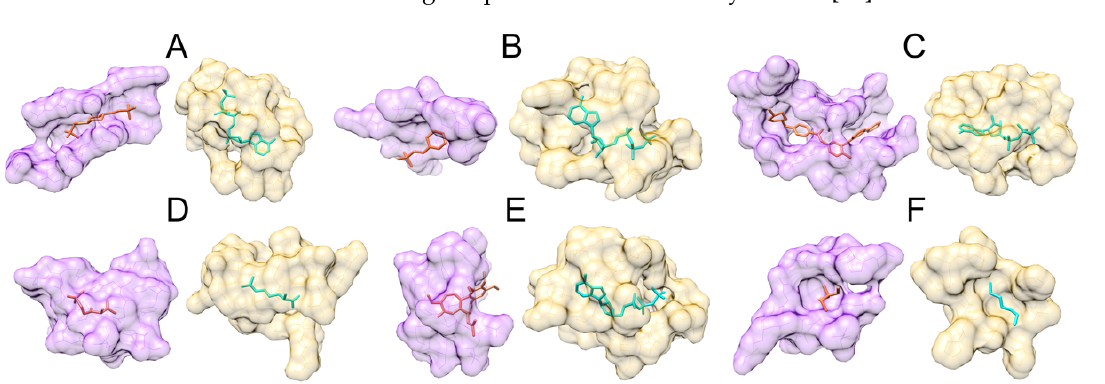
Figure 4. Structure alignments between misclassified pockets and those belonging to the predicted class. ( A ) PIPES (orange sticks) binding site in CENP-E (purple surface) and ATP (cyan sticks) binding site in FGAM synthase II (yellow surface). ( B ) MES (orange sticks) binding site in zitR (purple surface) and ATP (cyan sticks) binding site in FGAM synthase II (yellow surface). ( C ) Imatinib (orange sticks) binding site in ANC-AS (purple surface) and ATP (cyan sticks) binding site in FGAM synthase II (yellow surface). ( D ) (3R)-3-hydroxy-2,4-dioxopentyl dihydrogen phosphate (orange sticks) binding site in LsrF (purple surface) and arginine (cyan sticks) binding site in AT (yellow surface). ( E ) Colchicine (orange sticks) binding site in BRD4 (purple surface) and ATP (cyan sticks) binding site in FGAM synthase II (yellow surface). ( F ) Tromethamine (orange sticks) binding site in MAT (purple surface) and di(hydroxyethyl)ether (cyan sticks) binding site in BtR318A (yellow surface).